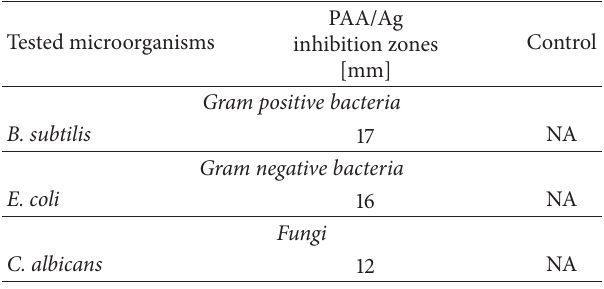
Table 2: Antimicrobial activity of prepared films by disc diffusion agar technique, inhibition zones measured in mm.